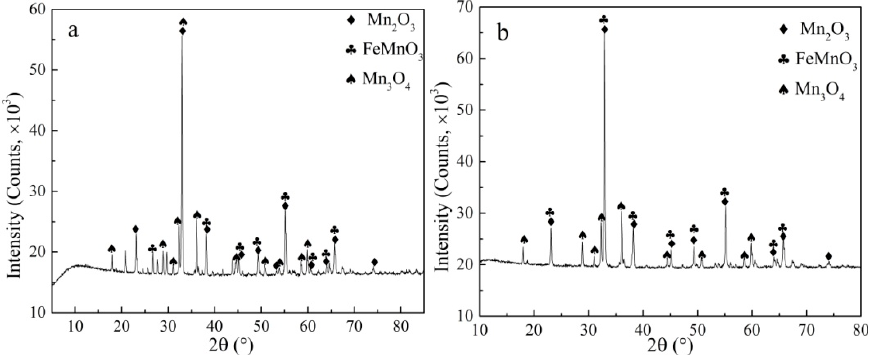
Figure 14. XRD of leaching residues under conventional and ultrasonic conditions. ( a ): XRD at conventional conditions; ( b ): XRD at ultrasonic conditions.